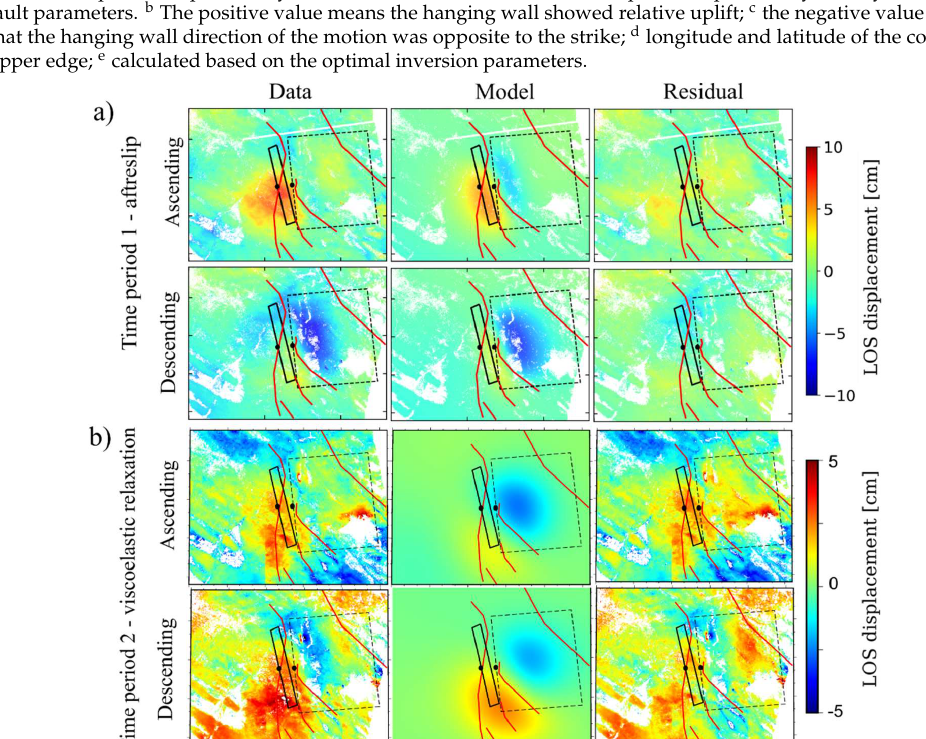
Optimal a maximum posteriori probability solutions of 2.5% and 97.5% from the posterior probability density function of fault parameters . b The positive value means the hanging wall showed relative uplift; c the negative value means that the hanging wall direction of the motion was opposite to the strike; d longitude and latitude of the corner of upper edge; e calculated based on the optimal inversion parameters.